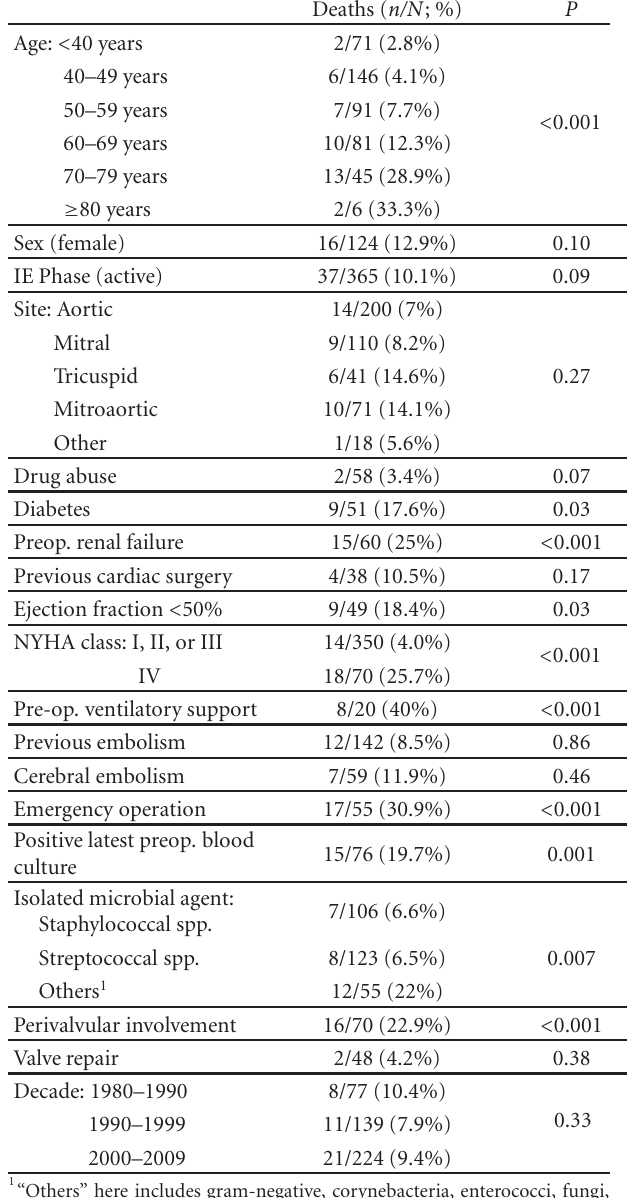
Table 1: Bivariate correlates of hospital (30-day)